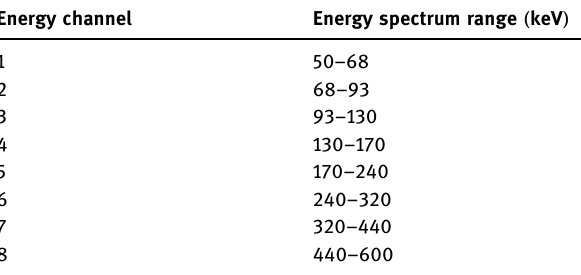
Table 1: Energy spectrum range of BeiDou MEO moderate -